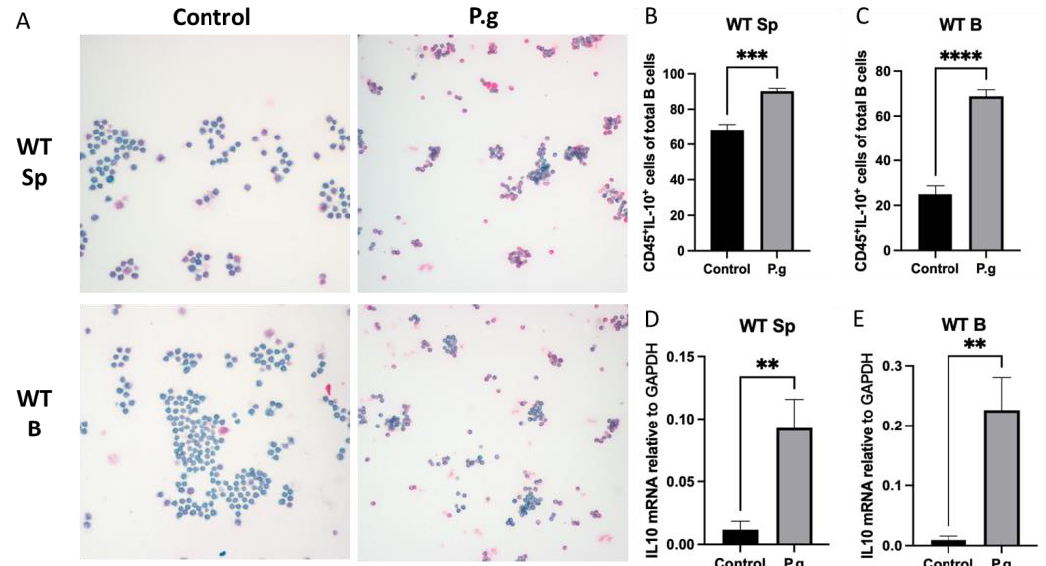
Figure 1. Under P. gingivalis stimulation for 24 h, the CD45 + IL-10 + cells and IL-10 mRNA level of splenocytes and B cells isolated from pre-immunized wild-type mice were calculated. ( A ) The representative ICC images of CD45 + IL-10 + cells in each group. CD45+ cells were labeled with rat anti-mouse CD45 antibody conjugated with emerald anti-rat antibody (blue) and IL-10+ cells were labeled with goat anti-mouse IL-10 antibody conjugated with permanent red anti-goat antibody (red). ( B , C ) The percentage of CD45 + IL-10 + cells among splenocytes ( B ) and B cells ( C ) were calculated based on cell immunocytochemistry staining. ( D , E ) The IL-10 mRNA expression in splenocytes ( D ) and B cells ( E ) were analyzed by quantitative RT-PCR. The data were shown as mean ± SD; significance calculated by unpaired t -test was indicated as ** p < 0.01, *** p < 0.001, **** p < 0.0001 (n = 5).